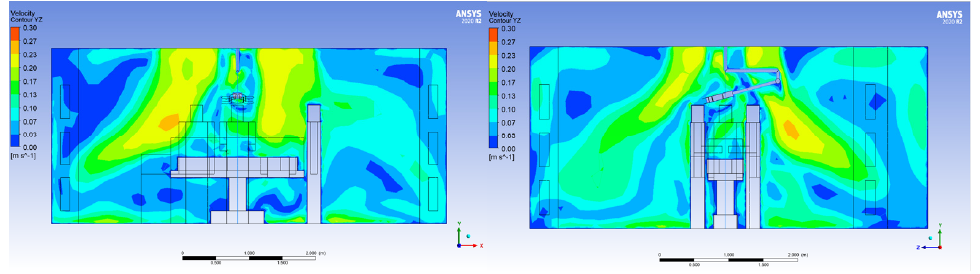
Figure 9. Air velocity profiles for variant 3 on the XY plane ( left ) and YZ ( right ).